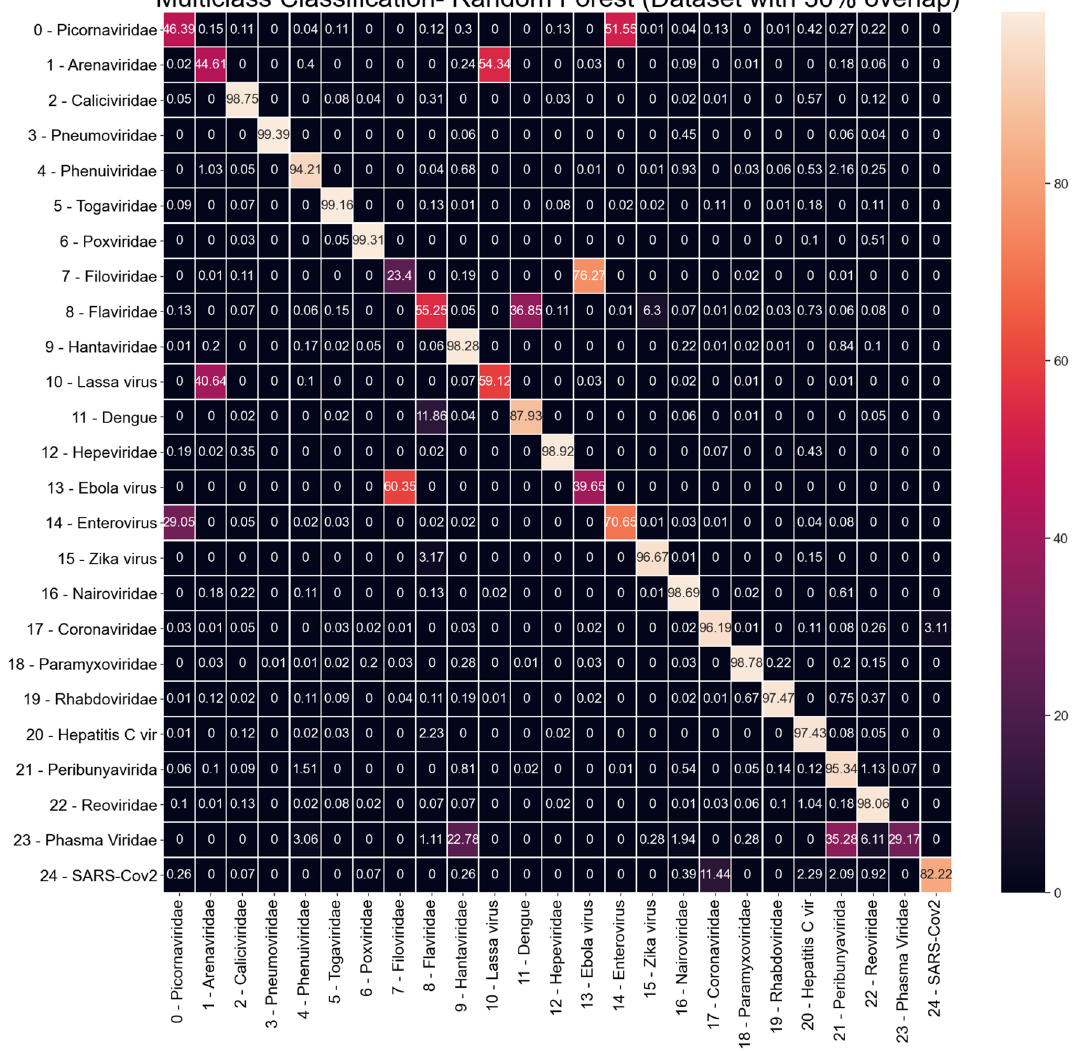
Figure 8. Random Forest average Confusion Matrix (results from dataset with 30%